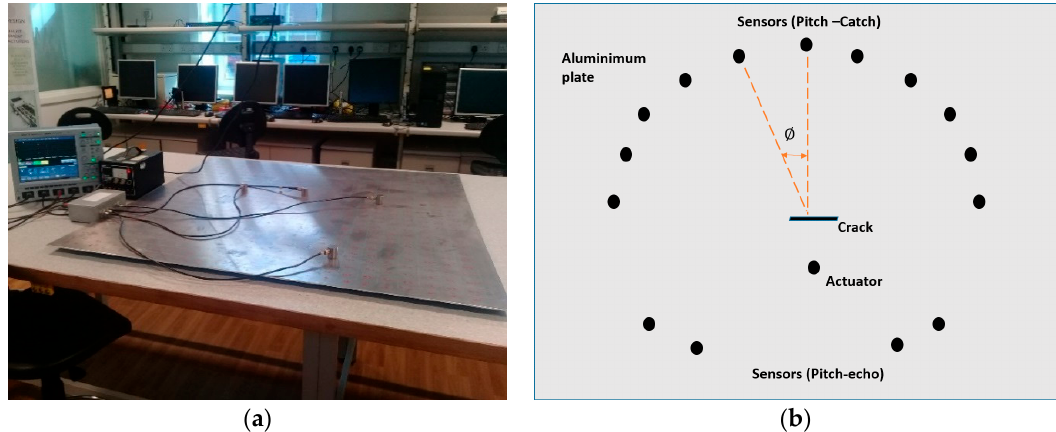
Figure 13. Proposed experimental set-up ( a ) and methodology ( b ) for placement of piezoelectric transducers.